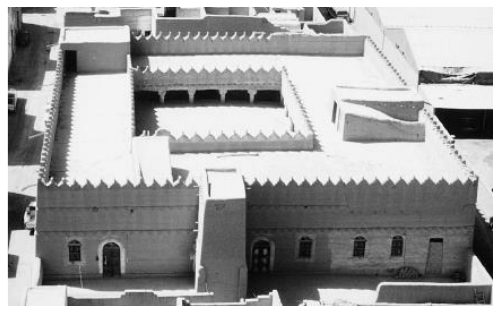
Figure 3. The vernacular house of the Najd type [53].